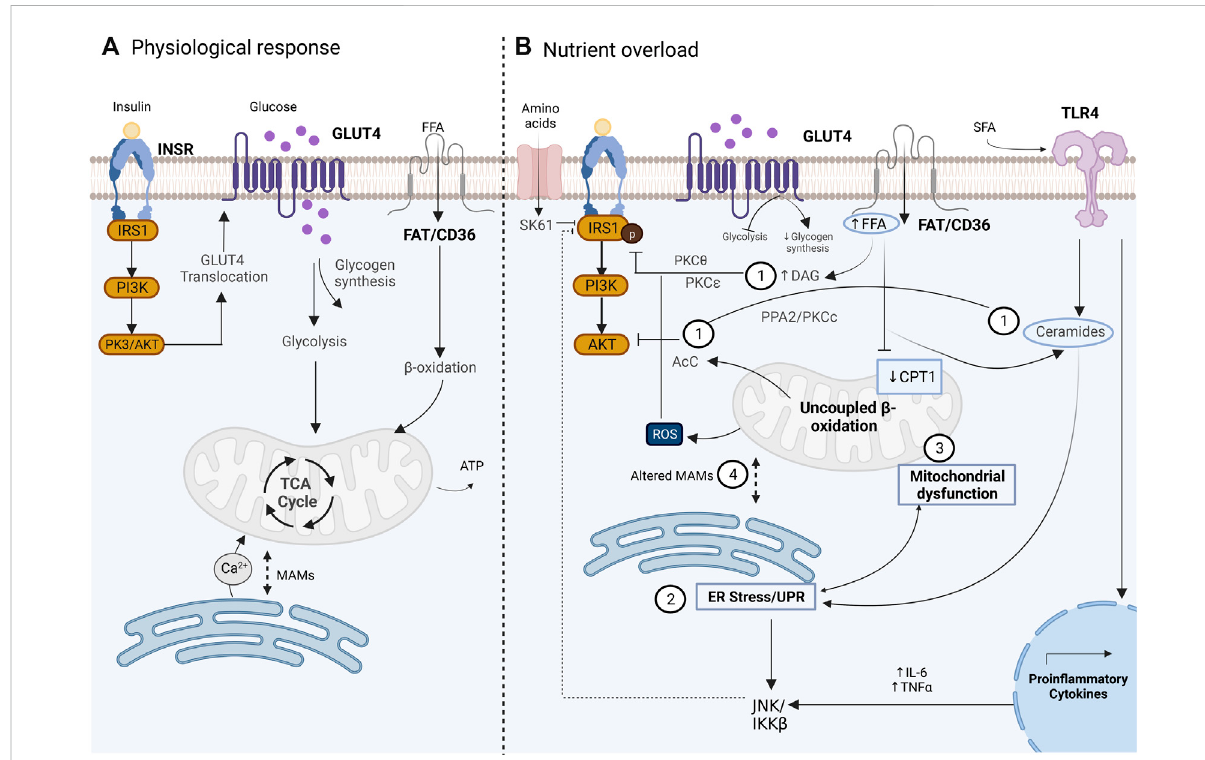
FIGURE 1 Glucose uptakeintheskeletalmusclecellunderphysiologicalconditions mediatedbytheinsulinpathway (A) Altereddisrupted glucose uptake during insulin resistance pathology related to an overnutrition state and the main related contributors. (B) 1) lipid intermediates such as DAG, ceramides, and AcC which have been associated with altered activity of IRS1 and AKT. 2) UPR activation during ER stress with a not clear subjacent mechanism, but proposals include JNK activation which affects insulin signaling. 3) Mitochondrial dysfunction is related to altered fatty acid oxidation and increased ROS production. 4) Altered MAMs that affect the signal transduction between ER and mitochondria. Image created with